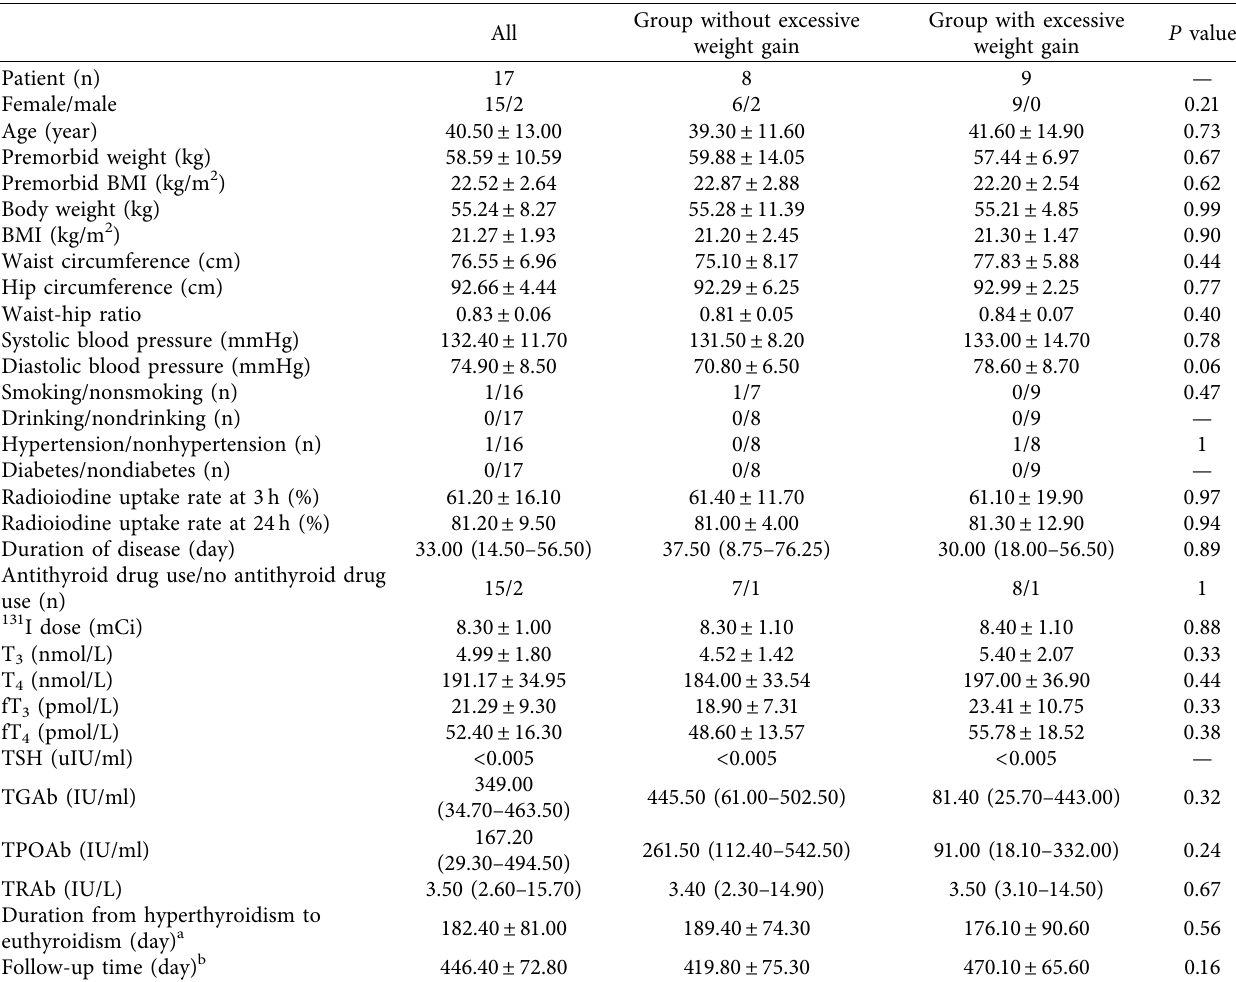
Table 1: Baseline characteristics of patients treated with 131 I for